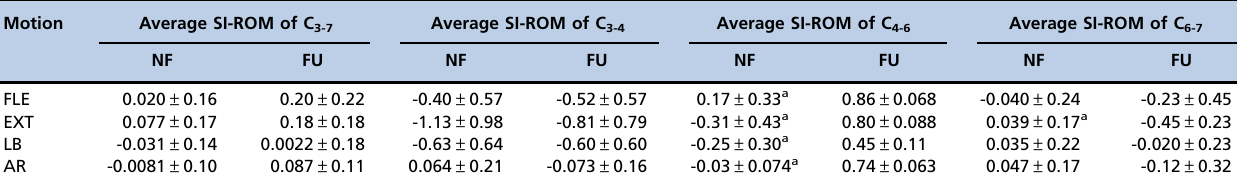
Table 3 - Stability Index of the Flexibility